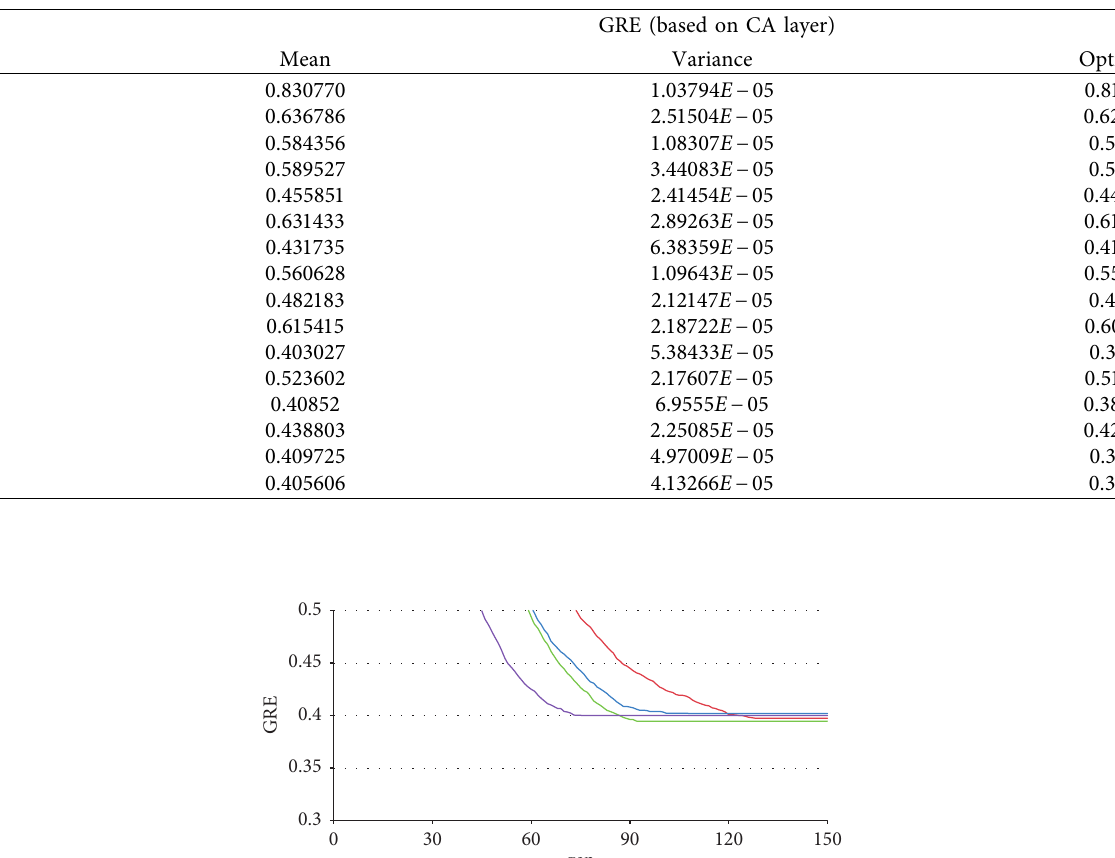
Table 7: The statistics of GRE.